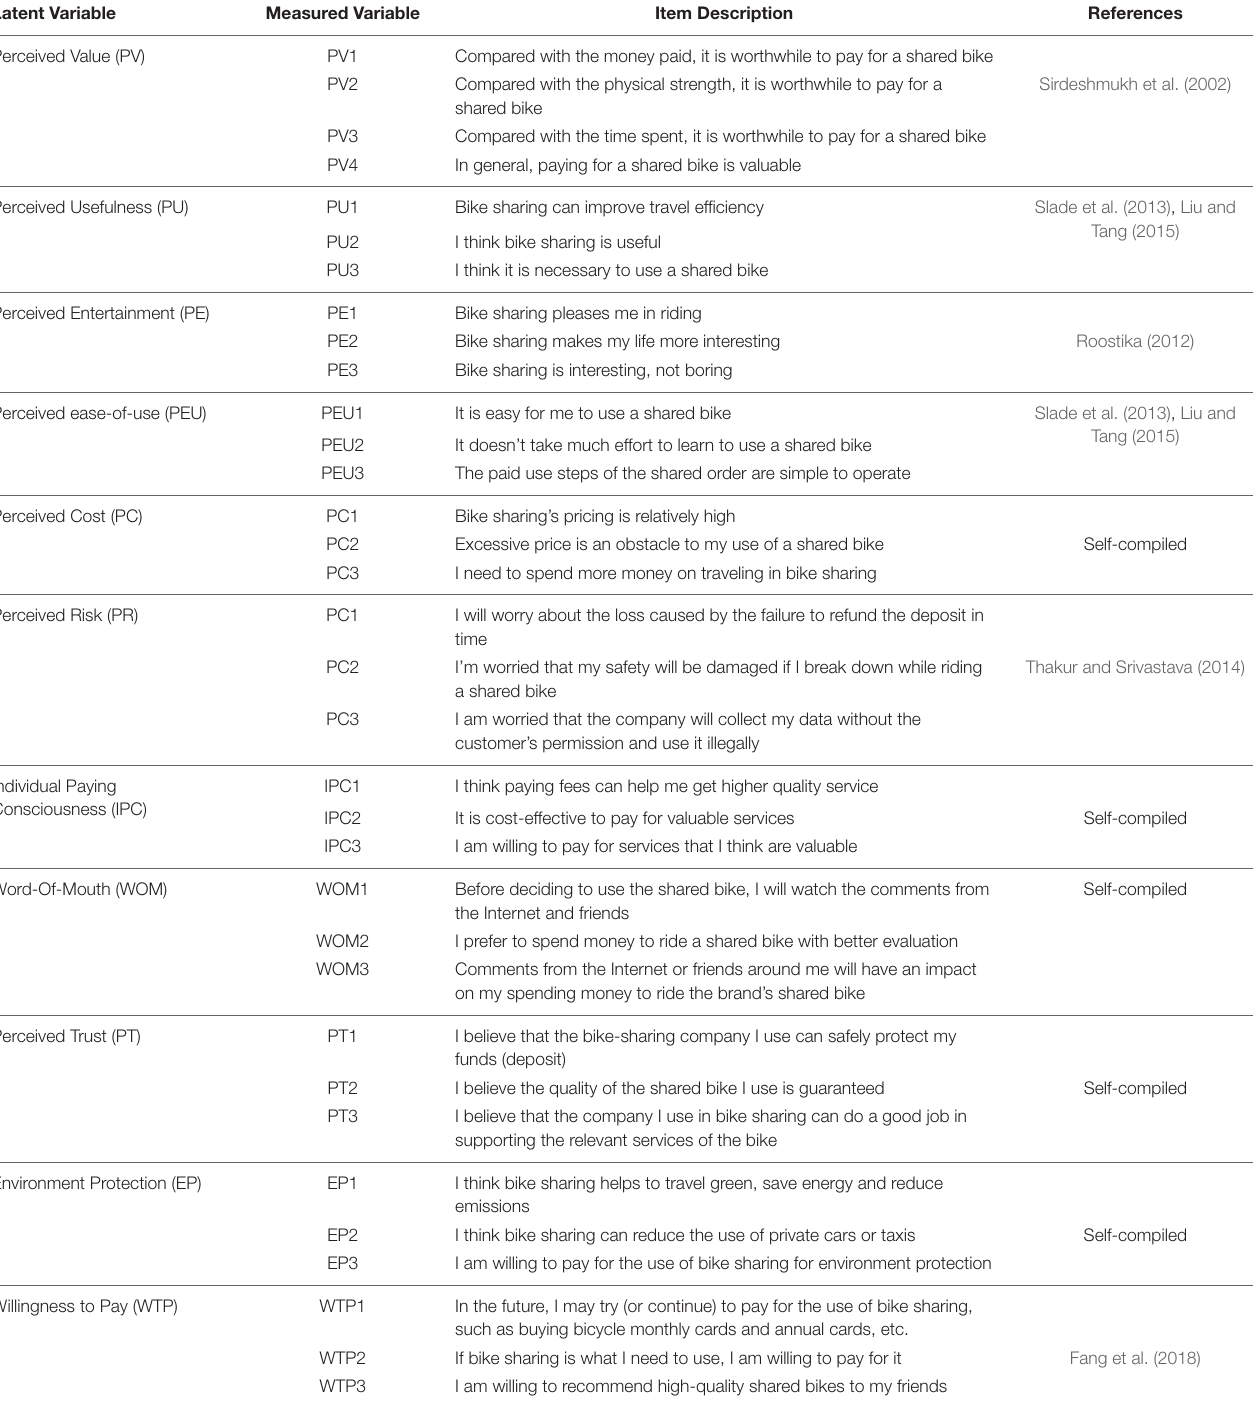
TABLE 1 | Statistics of the measurement